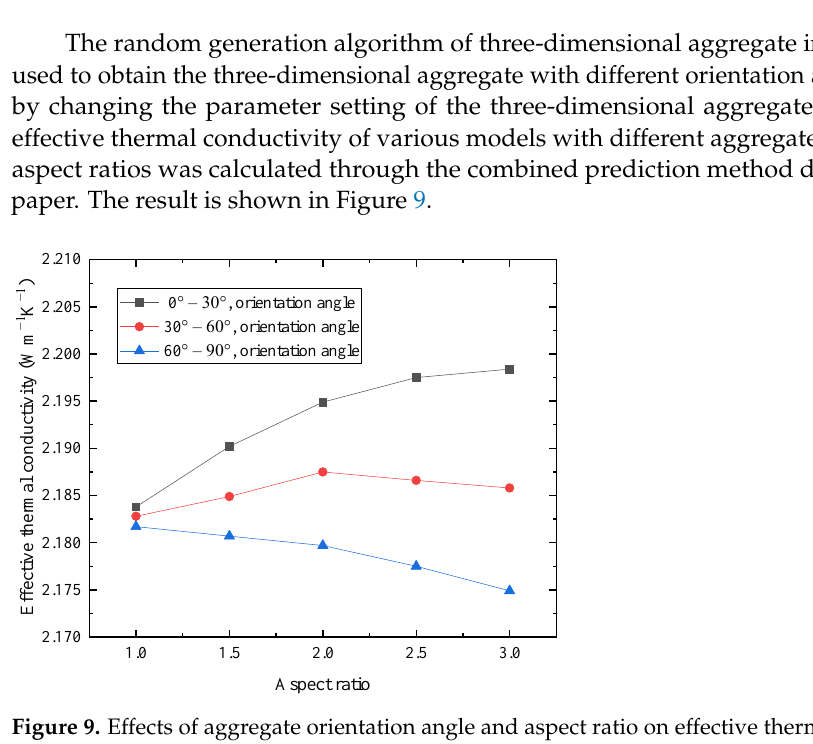
Figure 9. Effects of aggregate orientation angle and aspect ratio on effective thermal conductivity.